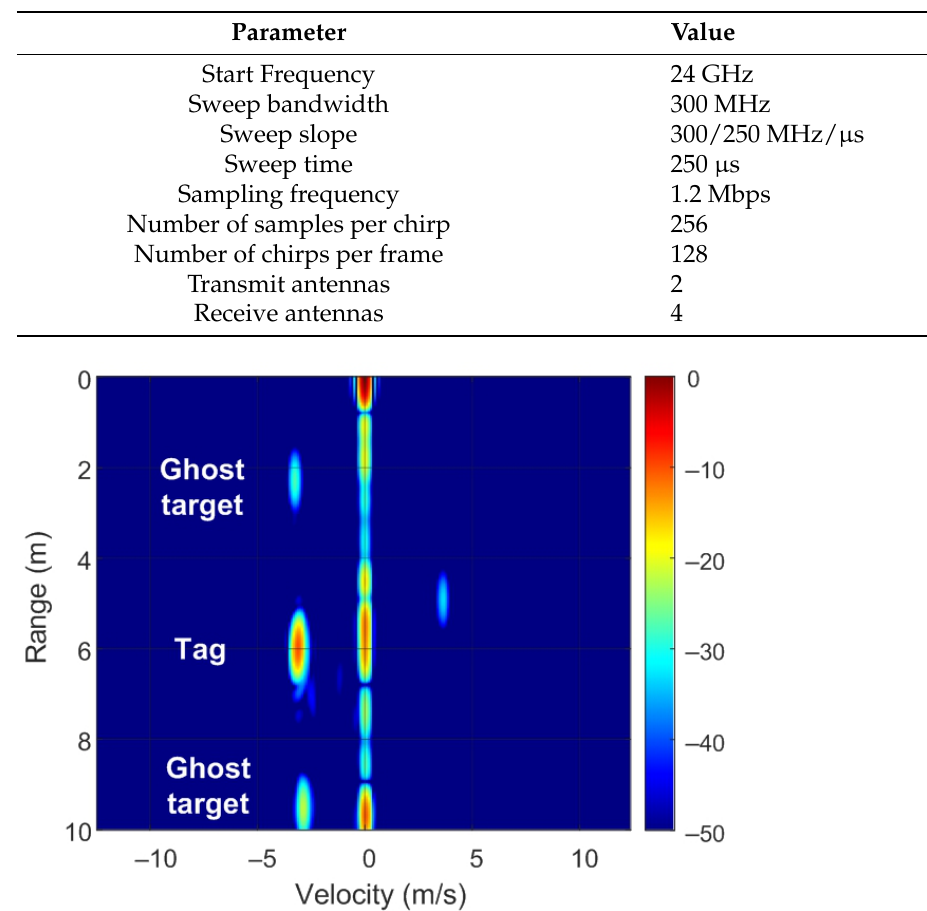
Figure 17. Measured range–Doppler map including two ghost targets generated with a Doppler frequency shift of 1000 Hz keeping the tag static. Table 3. Configuration of the FMCW radar.